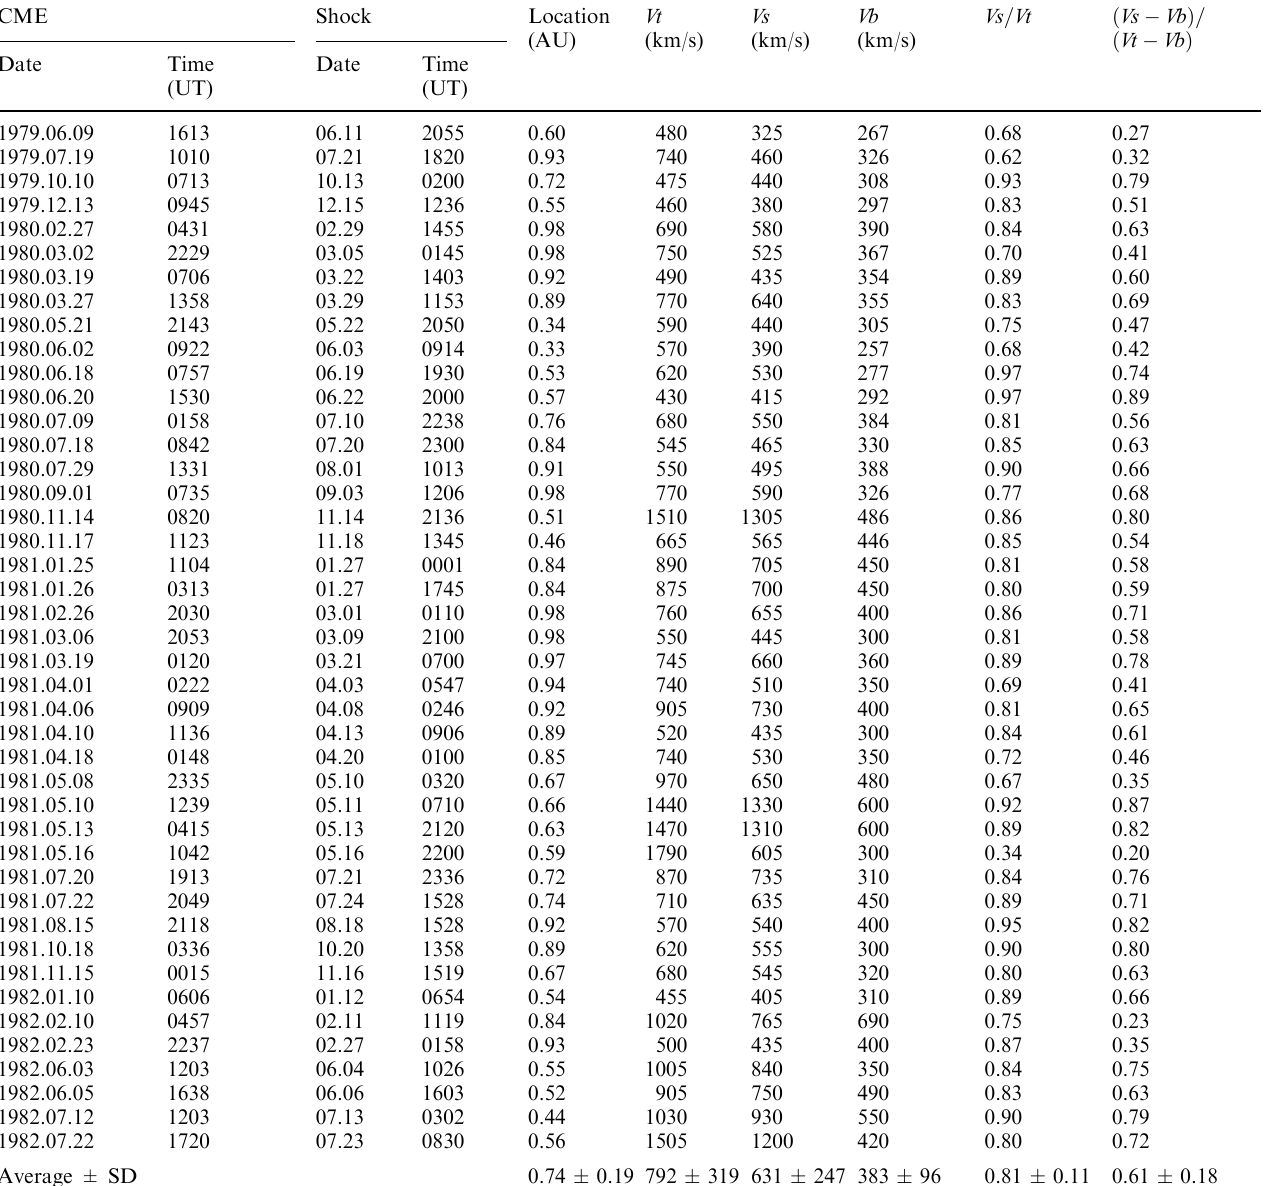
Table 2. Forty four interplanetary shocks observed by the HELIOS-1 spacecraft based on Sheeley et al . (1985) CME